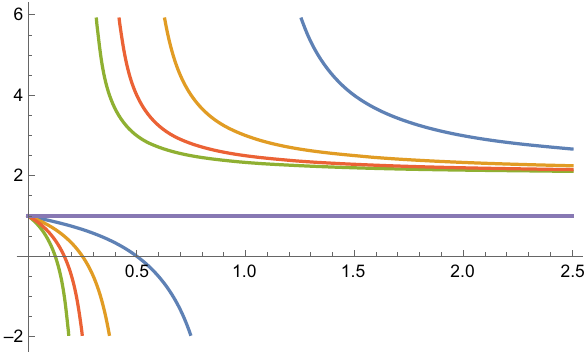
Fig. 1 Variation of F (ξ) as function of the dimensionless variable ξ ≡ ρ/ρ m for different values of the parameter line corresponds to w = 1 / 3. At low densities F (ξ) (cid:6) 1 and the RG behavior is recovered